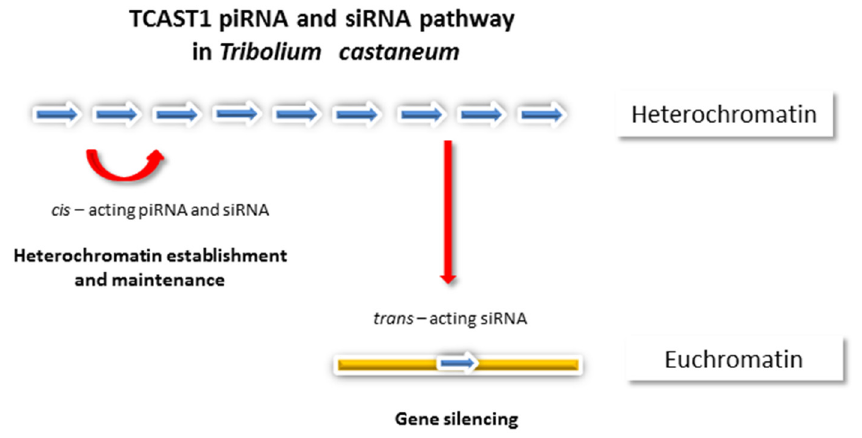
Figure 1. Role of major (peri)centromeric satellite DNA TCAST1 of beetle Tribolium castaneum in heterochromatin formation and maintenance as well as in gene silencing. TCAST1 transcripts are processed into piRNAs in germline and into siRNAs in the somatic cells. TCAST1 piRNAs and siRNAs are involved in the establishment and maintenance of heterochromatin, respectively, acting in cis at genomic loci from which they derive. The TCAST1 siRNA also acts in trans , affecting H3K9me3 level at euchromatic TCAST1 satellite elements and their neighbouring regions, influencing expression of genes located in the vicinity. The gene silencing effect is observed particularly upon heat stress coinciding with increased expression of TCAST1 satellite DNA. Blue arrows indicate TCAST1 satellite monomers. TCAST1 satellite